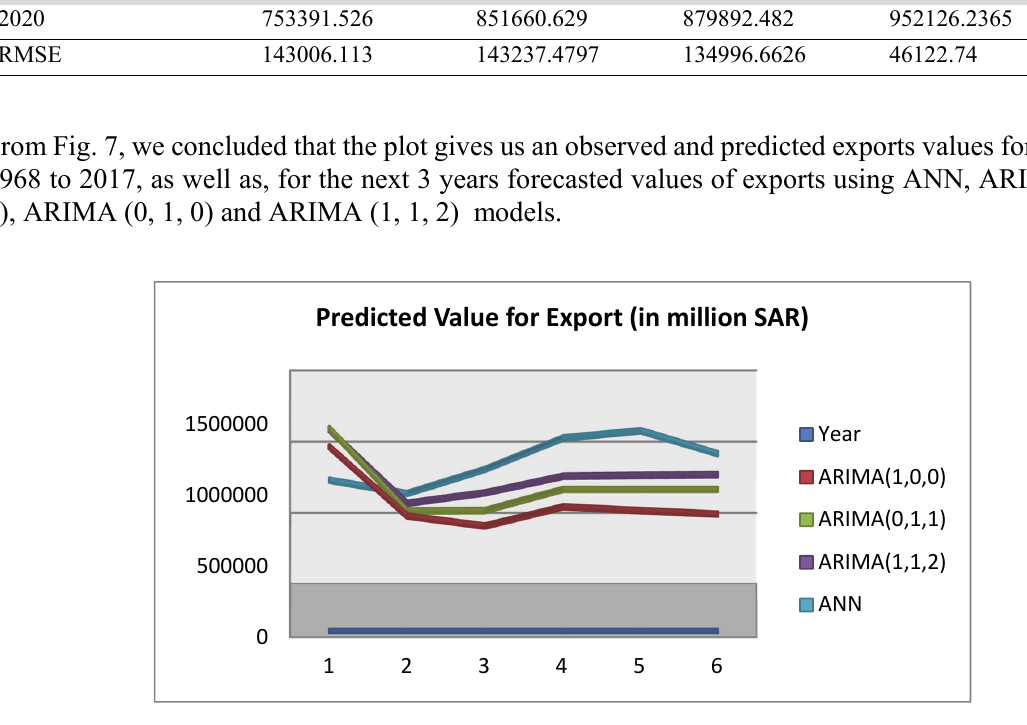
Fig. 7. Predicted Value for Export (in million